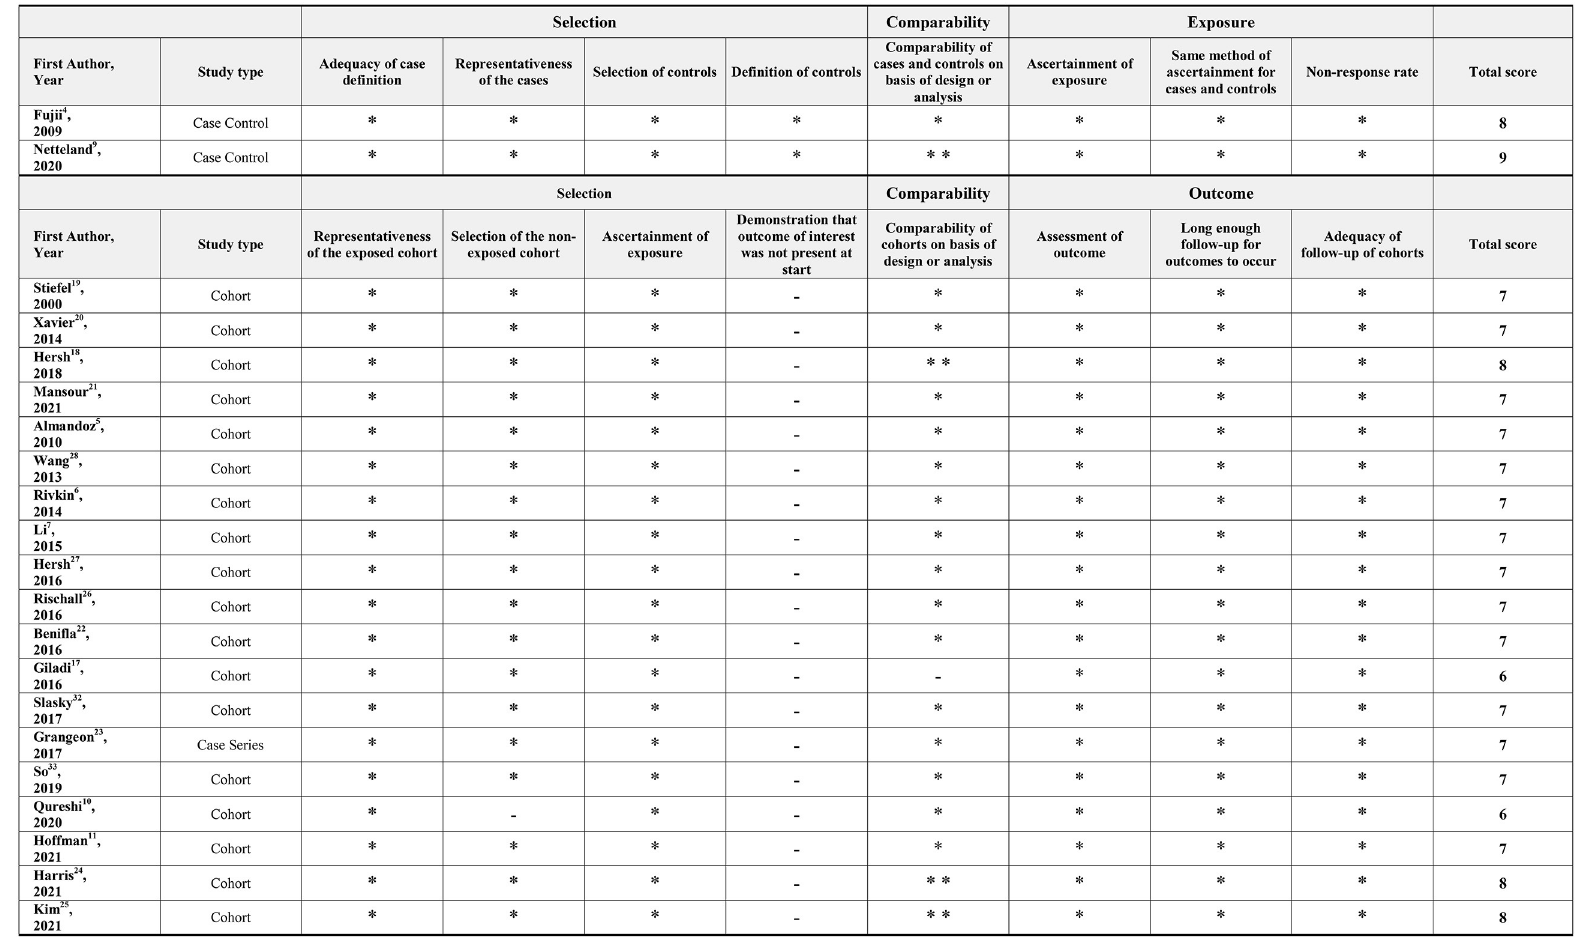
TABLE 3 Newcastle-Ottawa scale scores for included observational